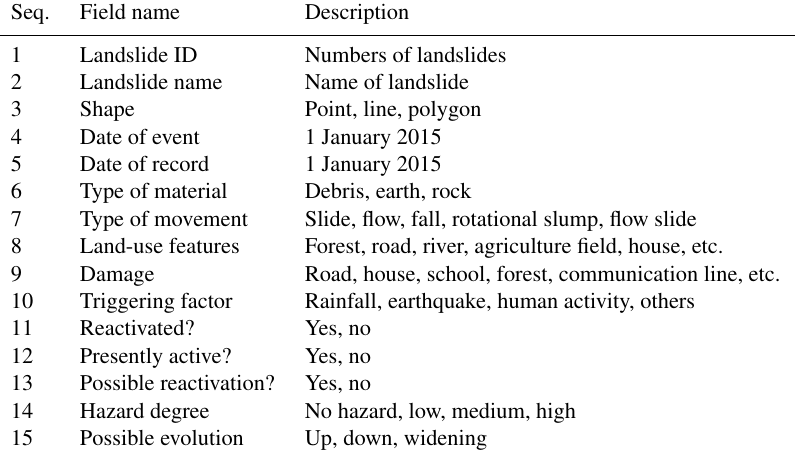
Table 1. Landslide data and their characteristics in the ROOMA database: landslide ID is given automatically, and landslide name and shape are obligatory